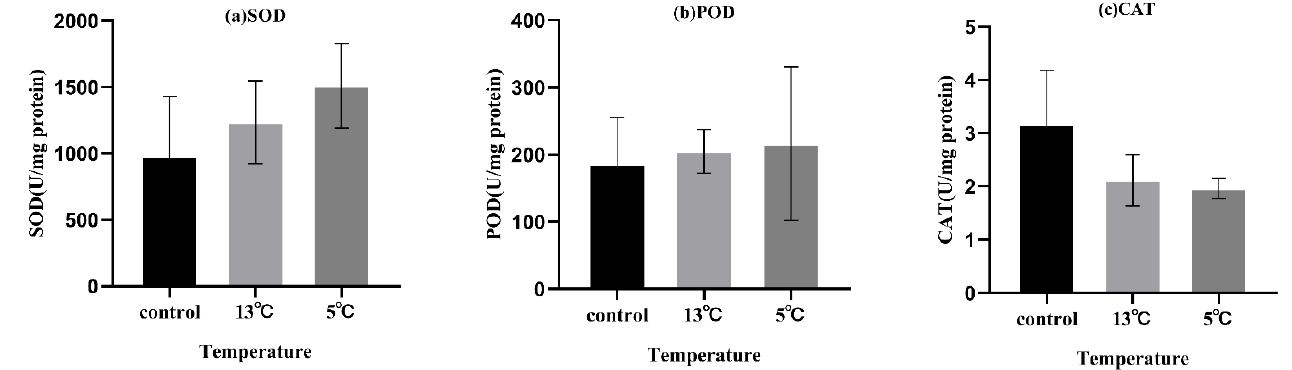
Figure 3. Effect of upwelling on SOD, POD, and CAT activity in the leaves of K. obovata. ( a ) SOD, superoxide dismutase; ( b ) POD, peroxidase; and ( c ) CAT, catalase. Values are presented as mean ± SD, and no significant differences were detected in these parameters ( p < 0.05).